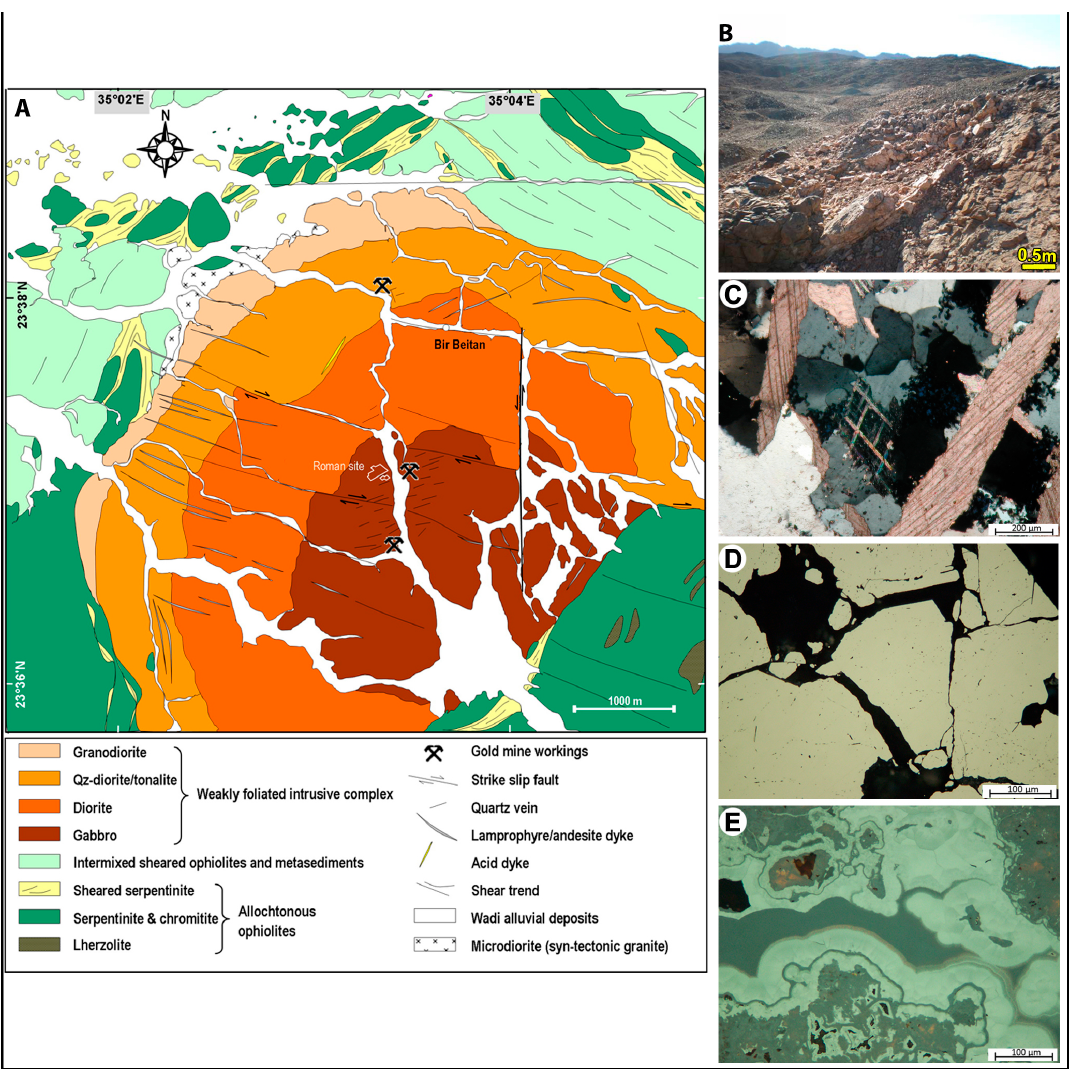
Figure 12. ( A ) Geological map of the Um Eleiga gold mine, modified from Zoheir et al. [71]; ( B ) milky quartz vein cuts across the gabbroic central part of the Um Eleiga intrusive complex; ( C ) transmitted, crossed polar light photomicrograph of the mineralized quartz veins showing dominant calcite, chlorite, and sulfide minerals; ( D , E ) Reflected light photomicrographs of the mineralized quartz veins showing disseminated euhedral to subhedral pyrite, and botryoidal malachite replacing chalcopyrite or other Cu-sulfides.